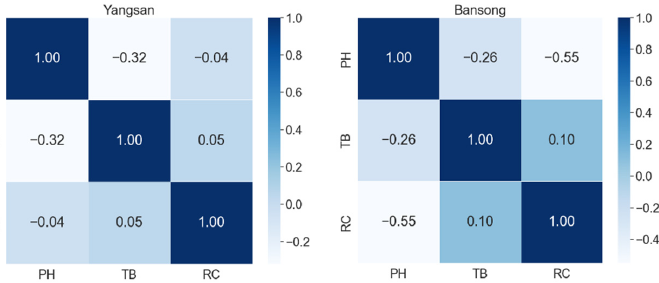
Figure 5. Spearman correlation coefficients for drinking water quality in the Geum River basin.